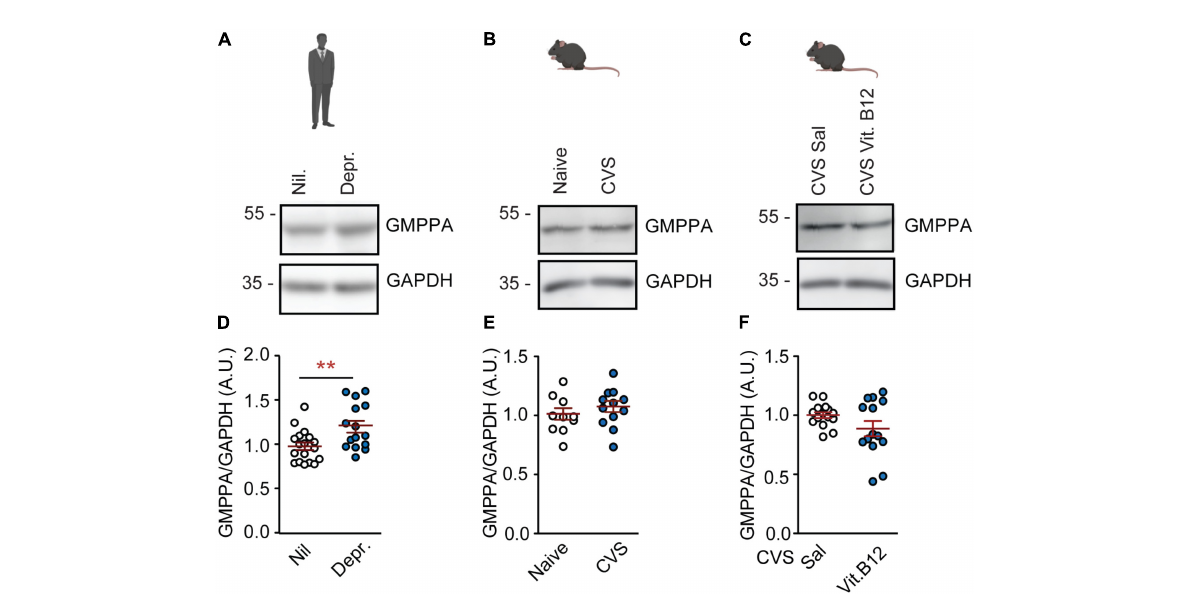
FIGURE3 GMPPA levels are not associated with depression or chronic stress in the PFC. (A) Representative western blots for GMPPA and housekeeping gene, GAPDH on prefrontal cortex tissue. (A) Human cohorts. (B) Naïve mice and CVS model. (C) Vitamin B12 treatment in stressed mice. (D–F) Statistics: Student’s t -test. (D) Increased GMPPA abundance in depression; n = 15–18 per group; t 31 = 2.91, ** P < 0.01. (E) GMPPA is not altered by chronic stress; n = 13–15 per group; t 26 = 1.10, P = 0.28. (F) Vitamin B12 does not affect GMPPA levels; n = 13–15 per group; t 26 = 1.95, P = 0.06. (D–F) Individual data points are plotted and means ± s.e.m. are shown. A.U., Arbitrary units. Illustrations were generated with